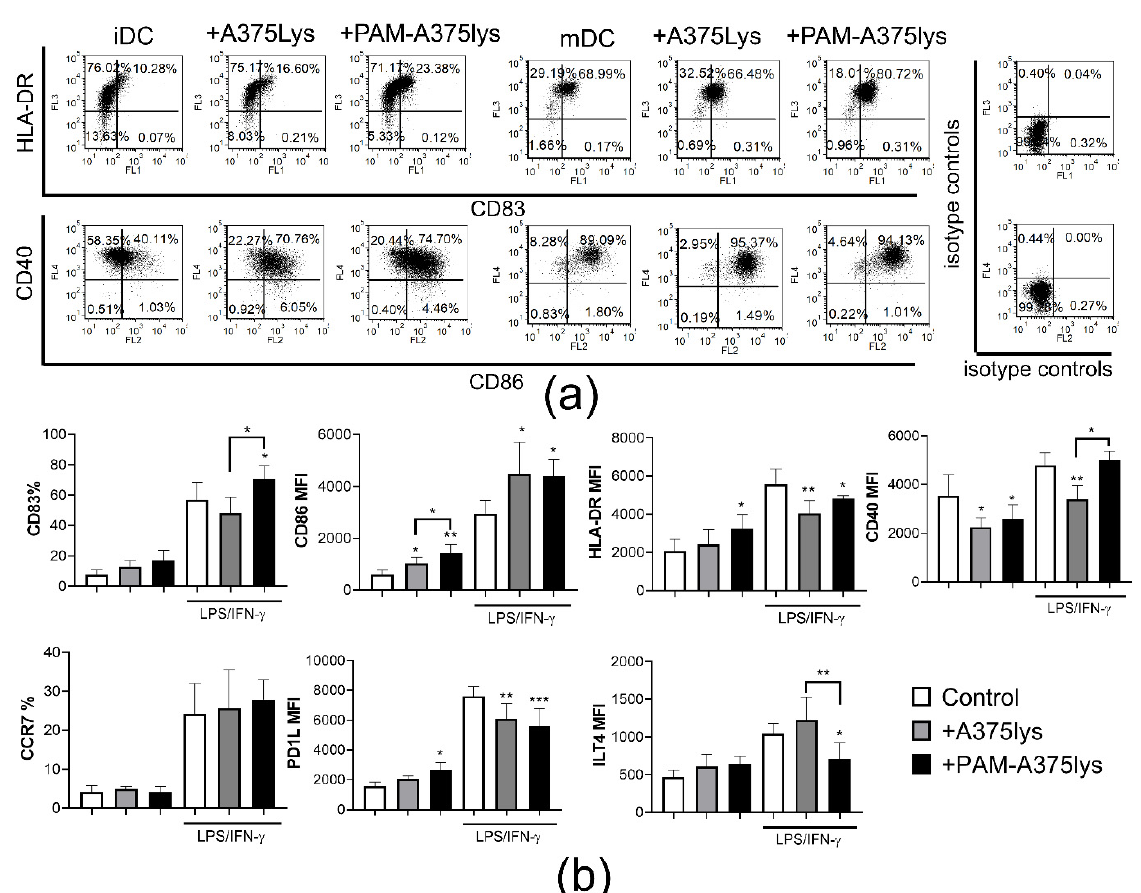
Figure 4. Effects of PAM-treated A375 lysates on phenotypic properties of DCs. Immature DCs differentiated for 4 days in the presence of GM-CSF/IL-4, were treated with the A375 lysate or the PAM-A375 lysate at 1:1 A375: DCs ratio, and after 4 h they were stimulated with LPS/IFN- γ or not, for the next 16 h. ( a ) A representative experiment on CD83/HLA-DR and CD40/CD86 co-expression analysis is shown and, ( b ) the summarized data from 3 independent experiments (different DC donors) are shown for the % of cells expressing the indicated surface marker, or as mean fluorescence intensity (MFI), ± SD. * p < 0.05, ** p < 0.01, *** p < 0.005 vs corresponding control DCs (white bars) or as indicated with lines (RM-ANOVA, Tukey’s multiple comparison test). Statistical significance between the corresponding iDCs and mDCs was not indicated for clarity.